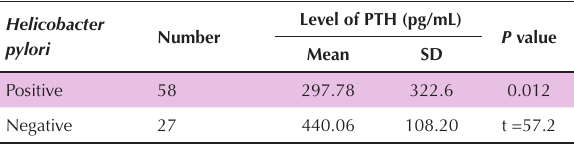
Table 4. Comparison of mean iPTH in patients with and without level of Helicobacter pylori antibody Helicobacter pylori